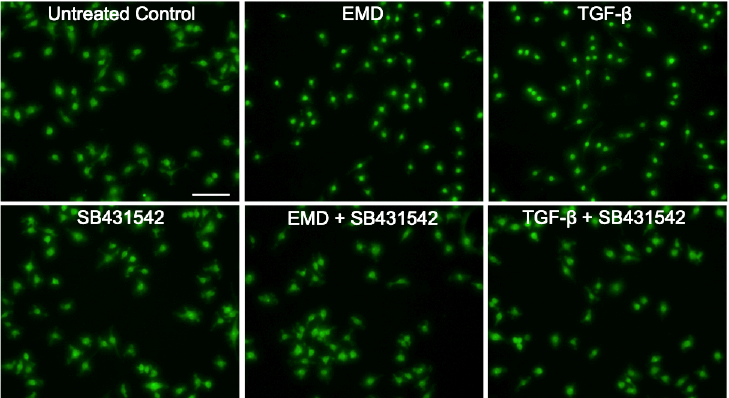
Figure 4. Smad2/3 immunofluorescence in RAW 264.7 cells. EMD and TGF- β attenuated the nuclear translocation of Smad2/3. Thepositive cells show a focused signal indicating the nuclear translocation of the Smad2/3 immunofluorescence. This effect was reversed with the application of SB431542, hence, the signal is more dispersed throughout the cytoplasm. SB431542 alone did not provoke changes in the nuclear translocation of Smad2/3. The scale bar represents 100 µm.